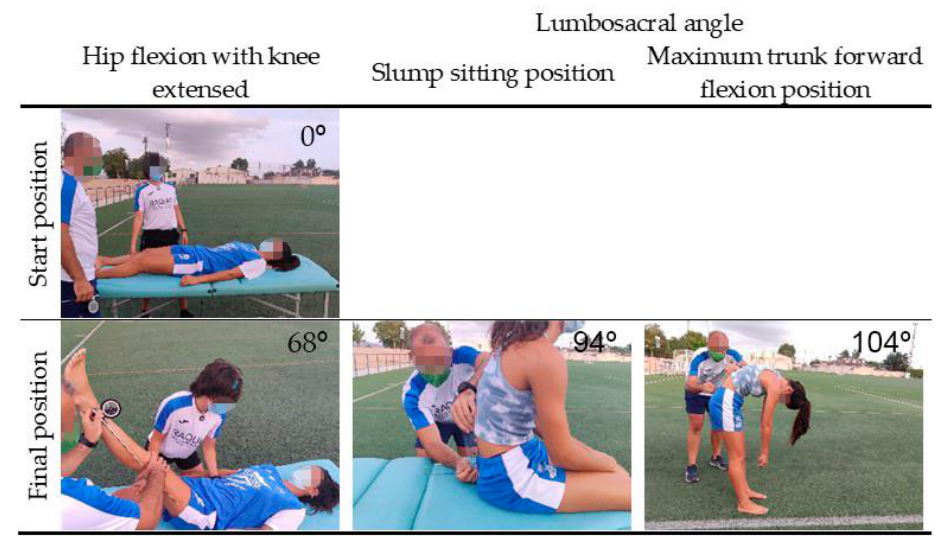
Figure 1. Assessment of hamstring extensibility (HE) and sagittal pelvic tilt.